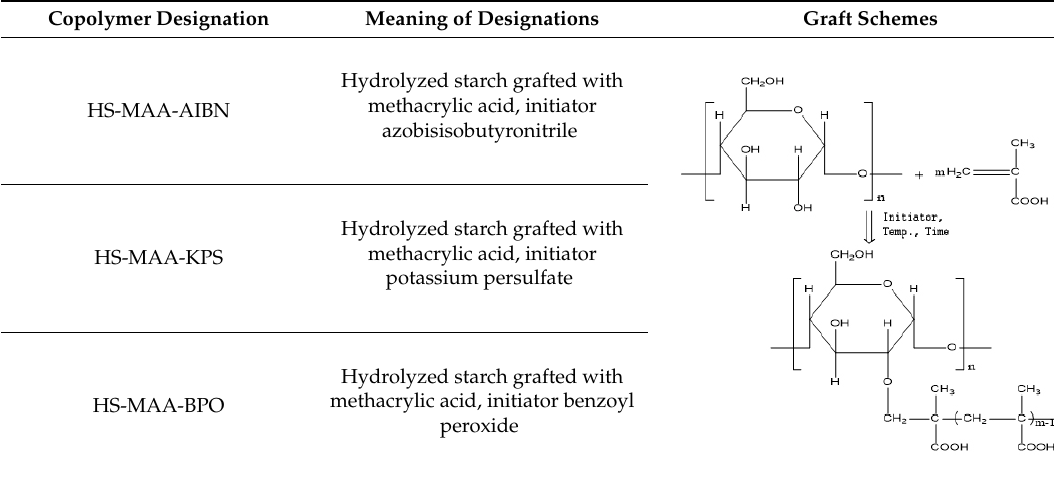
Figure 2. Laboratory sizing machine; 1—creel for cross wound bobbins, 2—thread tensioners, 3— comb, 4—tensiometer, 5—pump, 6—size box, 7—double wall of the size box, 8—thermostat, 9— prewetting size box, 10—immersion rollers, 11—size squeezing rollers, 12—contact dryer, 13— moisture measurement unit, 14—yarn winder, 15—computer with A/D converter for data storage. During the sizing process percentages of the copolymer solution in the water (concentration) for the single yarn were: 5%, 10% and 15%, and for the ply yarn: 1%, 3% and 5%, adapted to